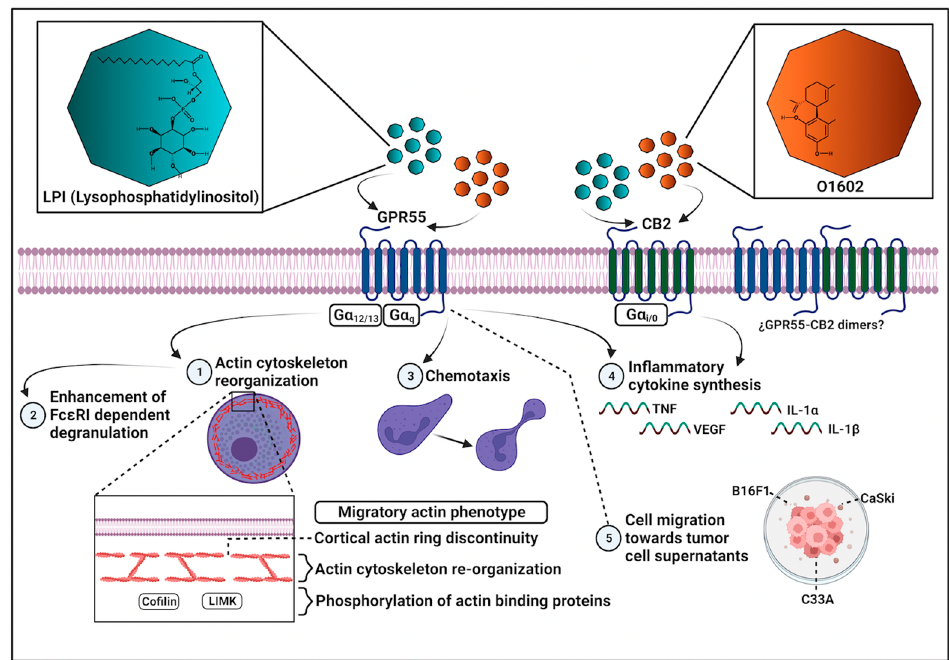
Figure 8. Overview of main LPI effects on chemotaxis, cytoskeletal rearrangements, and cytokine mRNA production in BMMCs. LPI promotes chemotaxis and changes in the actin cytoskeleton dynamics in BMMCs through GPR55 receptor activation, whereas its actions on cytokine mRNA accumulation partially require the participation of CB2 receptors. LPI also increases degranulation triggered by Fc ε RI. The GPR55 receptor is involved in BMMC migration to tumor cell-conditioned media. GPR55 agonist O1602 promotes chemotaxis and cytokine mRNA accumulation, but the latter e ff ect is dependent on CB2 receptors.